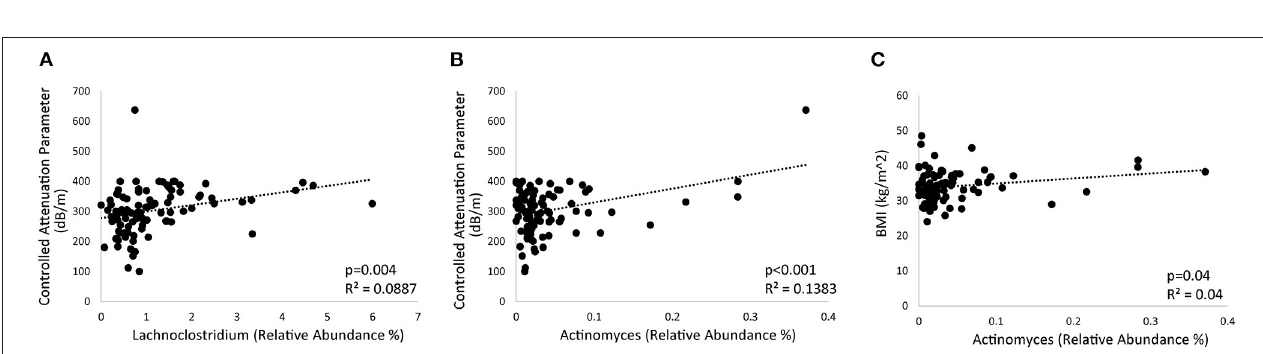
FIGURE 3 | Baseline microbiome differences between patients stratified by whether they achieved at least 5% weight loss or a reduction in hepatic steatosis on a calorie-restricted diet. (A) Bar plots showing baseline genera differences from DESeq2 analysis between patients who developed at least 5% weight loss as compared to those that did not. Red indicates genera that are overabundant in patients with < 5% weight loss. (B) Baseline genera differences between patients who had reduction in hepatic steatosis by CAP score as compared to those that did not. Red indicates genera that are overabundant in patients that did not have any reduction in steatosis.